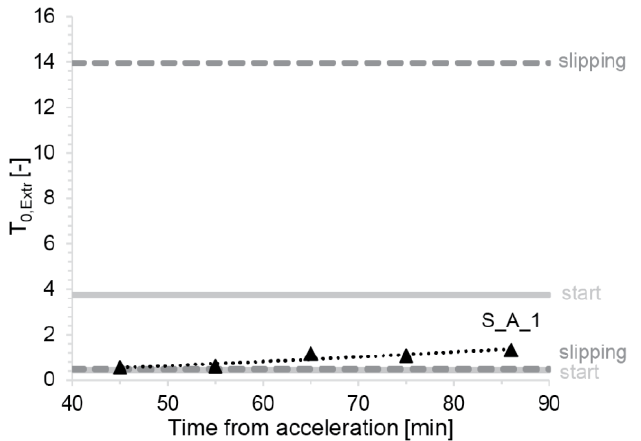
Figure A1. Heat flow over time from time of acceleration for the U mix accelerated with uniform dosage of aluminium sulfate.